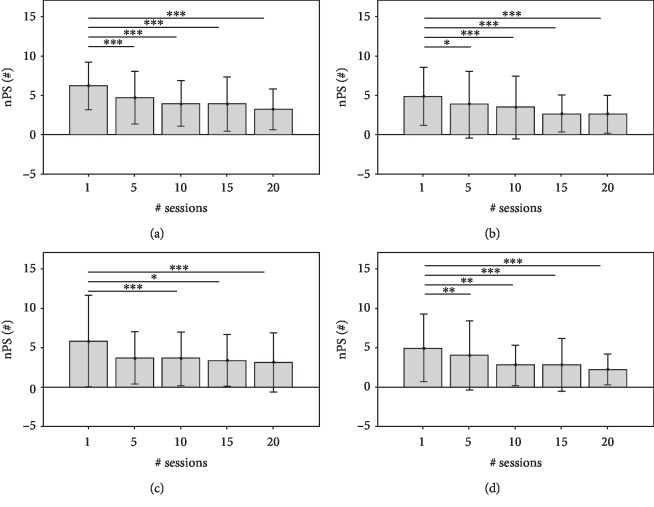
nPS values (mean and standard deviation) at 1st, 5th, 10th, 15th, and 20th sessions of RT and significant post hoc comparisons between sessions (Conover's test): ∗p value < 0.05; ∗∗p value < 0.001; ∗∗∗p value < 0.0001. The data obtained by analysing the end-effector trajectories towards the four targets (A, B, C, D) are showed separately.